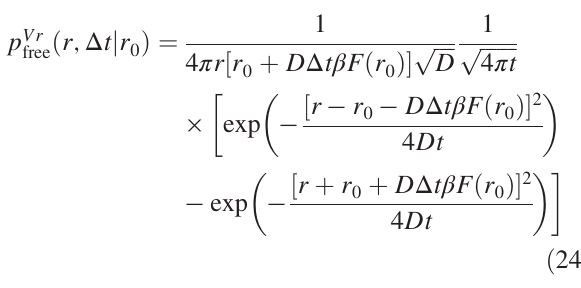
ffiffiffiffiffiffiffiffiffiffiffiffi p 2 D Δ t R ; ð 23 Þ